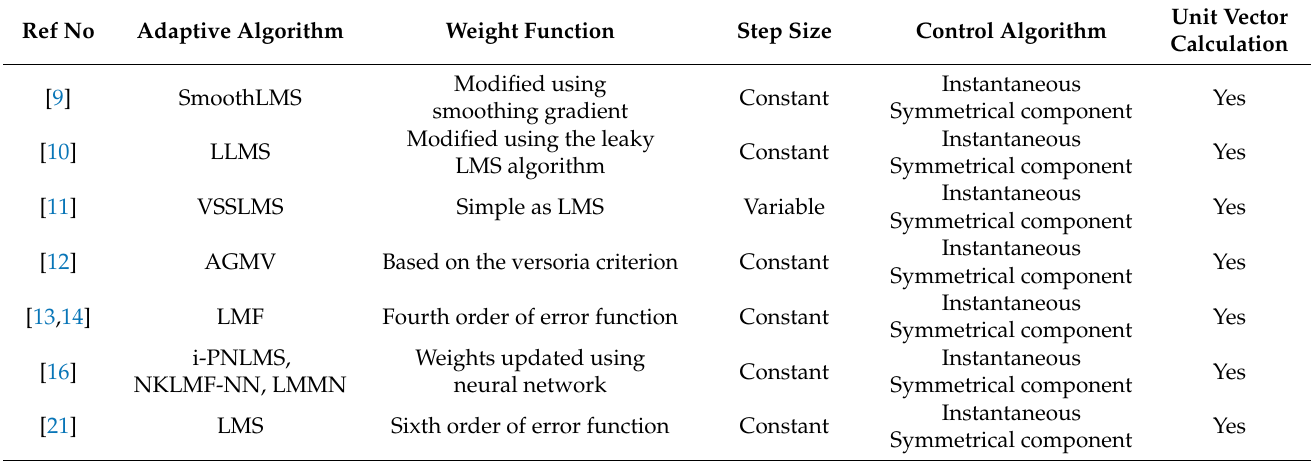
Table 1. Comparative study of the LMS family algorithm for control of the solar PV